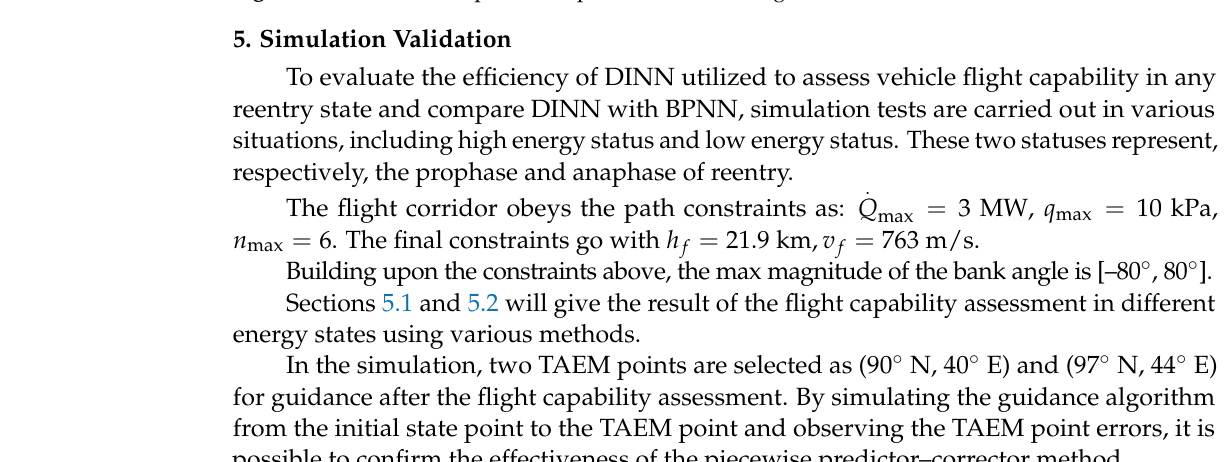
Figure 5. Framework of piecewise predictor–corrector guidance.